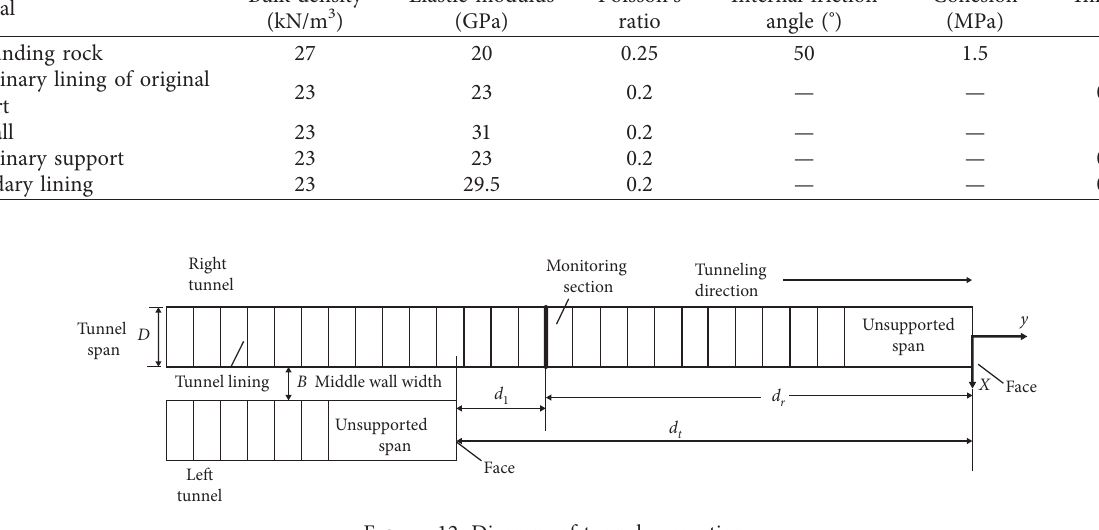
Figure 12: Diagram of tunnel excavation.